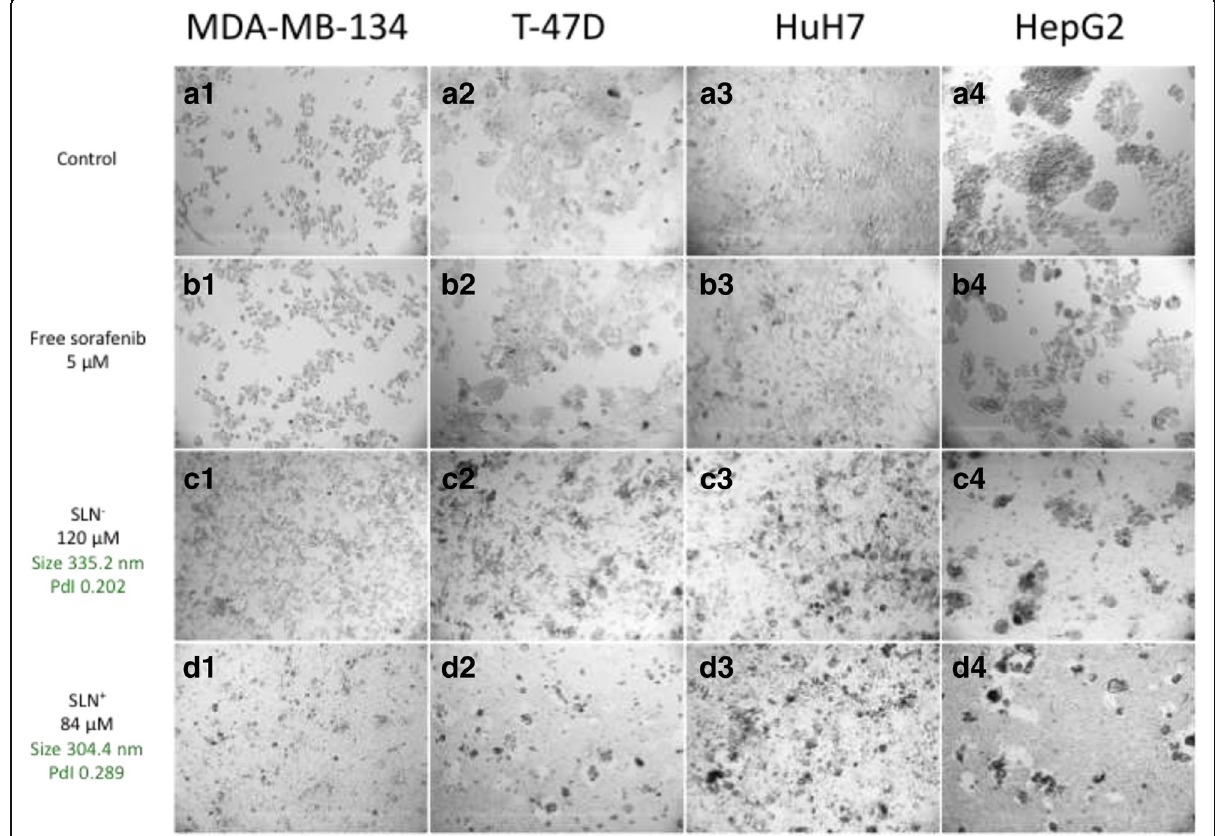
Fig. 5 Comparison of cells morphologies between control, free sorafenib, or SLNs. Phase contrast microscopy images showing cytotoxicity in different conditions on four human carcinoma cell lines (the hepatocarcinomas, HuH7, HepG2, and the luminal breast carcinoma MDA-MB-134, T-47D). A) In the absence of sorafenib (control experiments, A1 – A4 for MDA-MB-134, T-47D, HuH7, HepG2, cell lines, respectively). B) Cells were incubated for 4 days in the presence of 5 μ M of free sorafenib. C and D) cells incubated in the presence of SLN − and SLN + at 84 and 120 μ M in concentration of sorafenib,